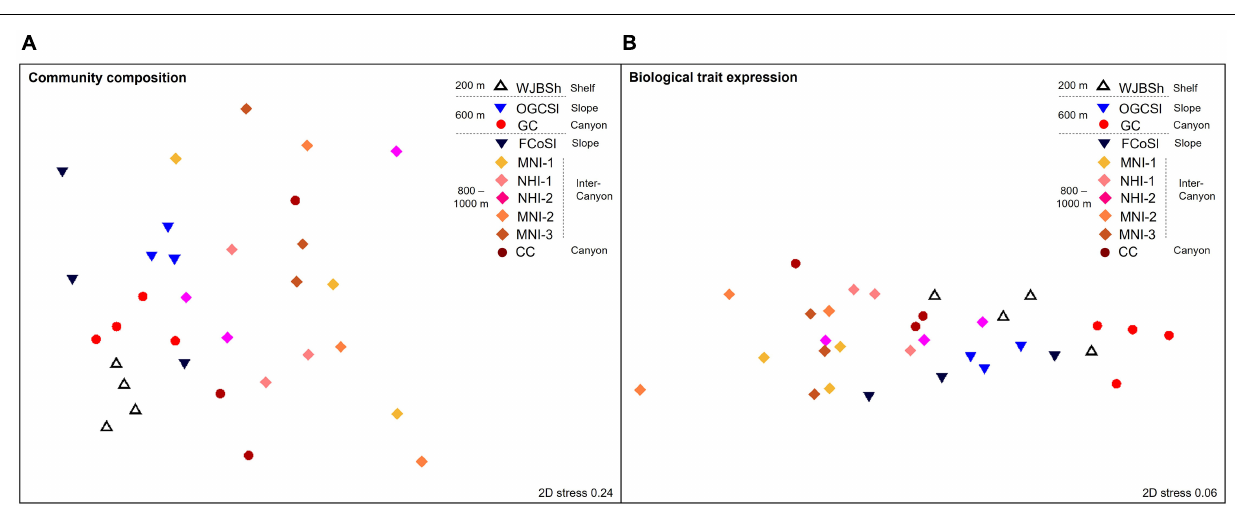
FIGURE 5 | (A) Non-metric multidimensional scaling (nMDS) of the macrofaunal communities in the 10 stations, based on Bray-Curtis similarity of square-root transformed density data. (B) Non-metric multidimensional scaling (nMDS) of the macrofaunal biological trait expression in the 10 stations, based on Bray-Curtis similarity of square-root transformed trait expression